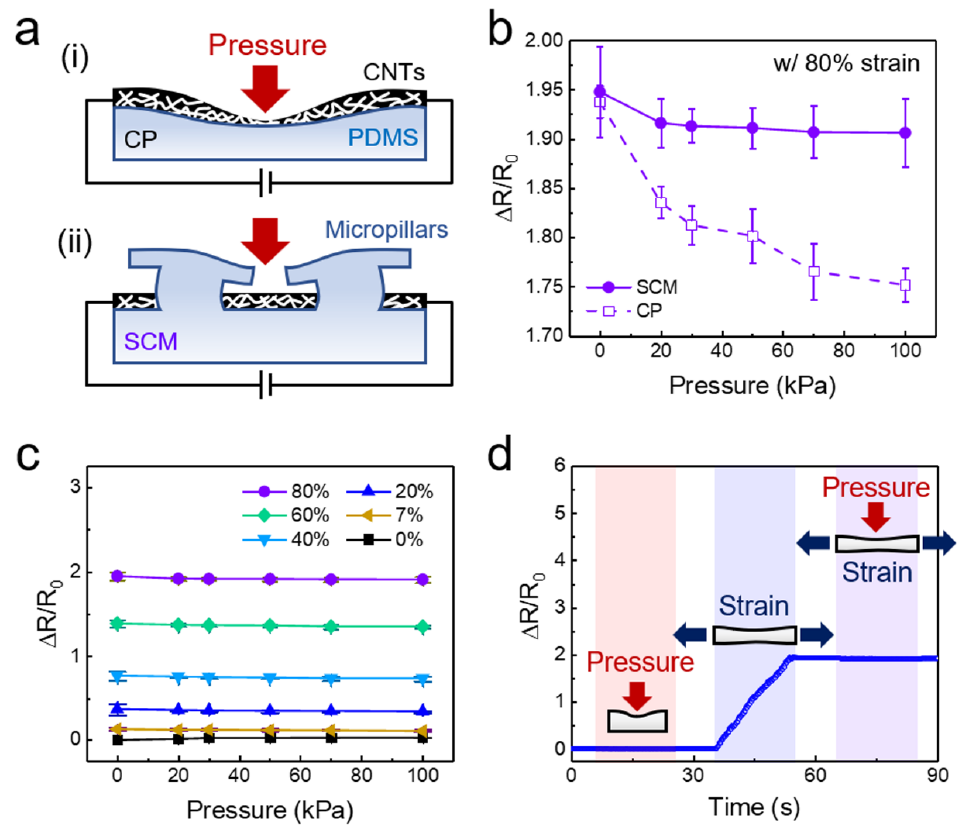
Figure 5. Strain-sensitive and pressure-insensitive property of the strain sensor. ( a ) ( i ) Schematic illustration showing the working principle of the CP sensor. ( ii ) Schematic illustration showing the pressure-insensitive working principle of the selectively MWCNT-coated micropillar (SCM) strain sensors. ( b ) Relative resistance changes measured by the CP and SCM sensors as a function of pressure (applied strain = 80%). ( c ) Relative resistance changes measured by the SCM sensor as a function of pressure for different strains (0–80%). The average values and error bars in ( b , c ) are based on five measurements. Error bars represent the standard deviation. ( d ) Time-resolved measurement of an applied pressure (100 kPa) and a strain (80%) with the SCM sensor.